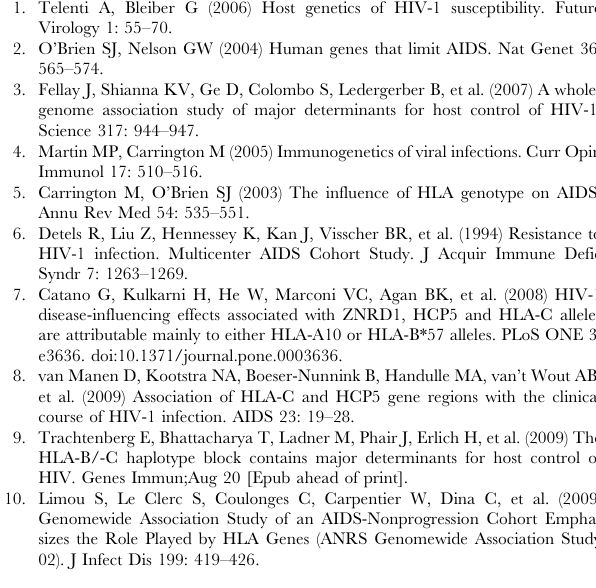
Table S9 Top 500 SNPs in the setpoint analysis.